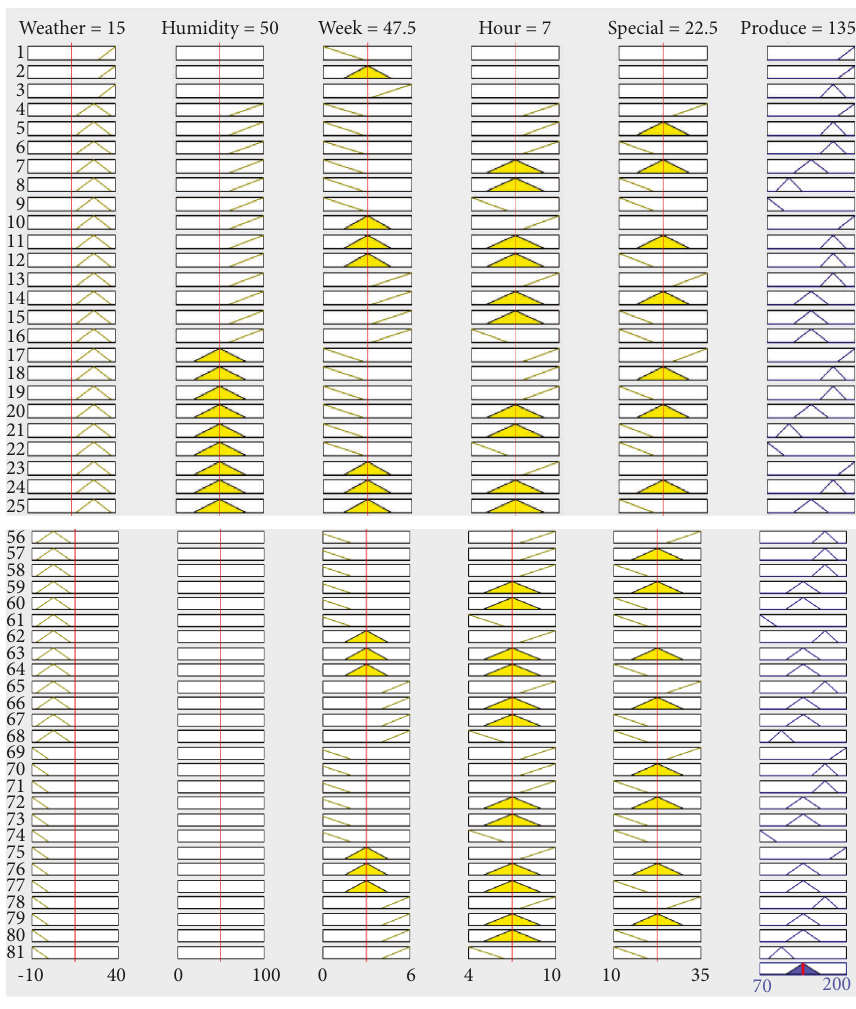
Figure 3: View of the rules designed in the MATLAB fuzzy rule window.